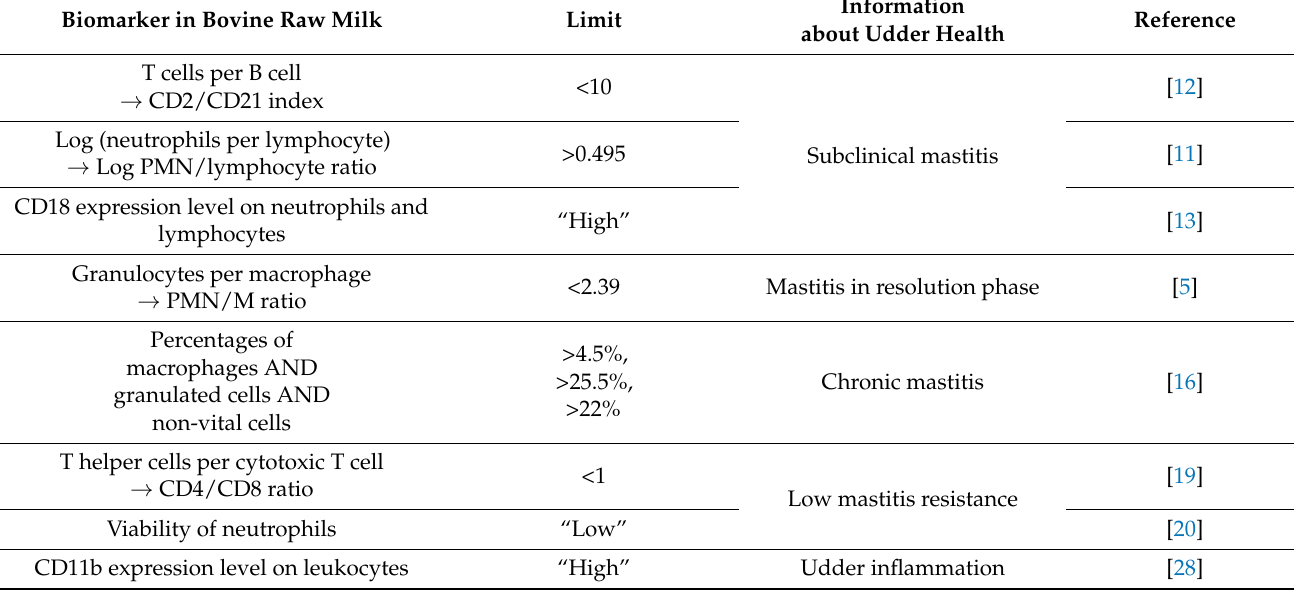
Table 1. Selected examples of DCC-based quotients or biomarkers that have been suggested for improving mastitis diagnostics. In the cited papers, differential cell counting was either conducted with standard cytology or laser-based flow cytometry techniques. CD = cluster of differentiation. Biomarker in Bovine Raw